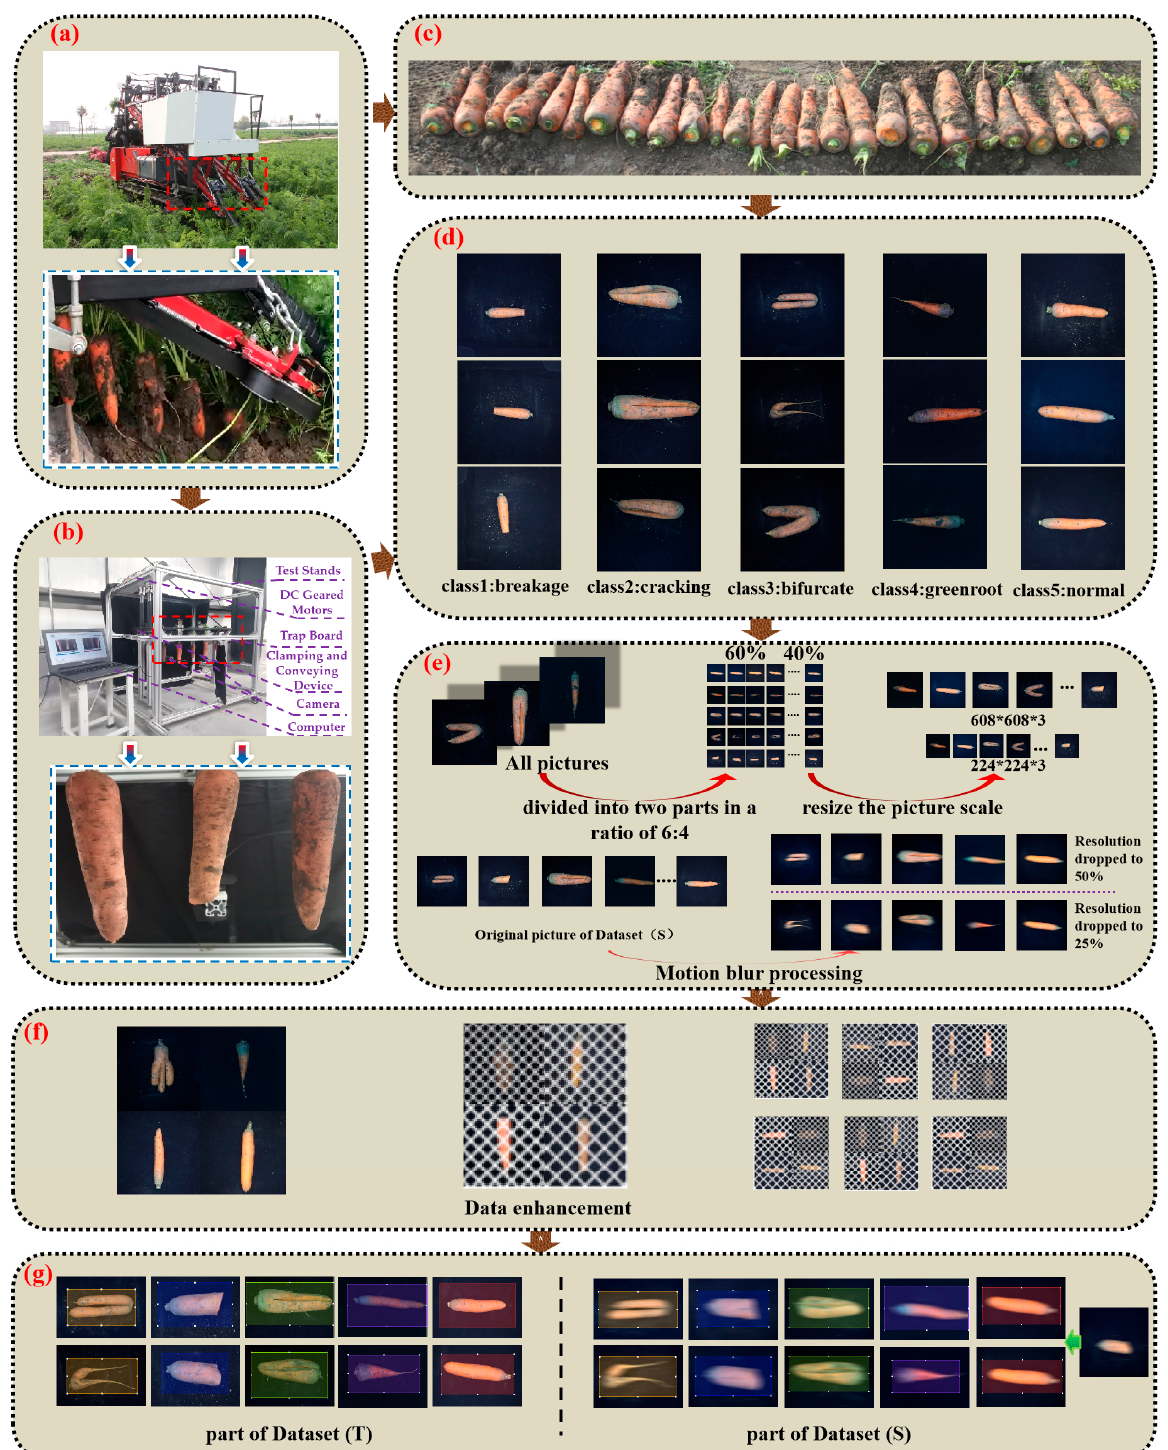
Figure 3. Acquisition of a carrot dataset. ( a ) Operation of the carrot combine harvester conveying system; ( b ) combine harvesting and collecting simulation system; ( c ) material acquisition for field tests; ( d ) classification of carrot defect types; ( e ) image preprocessing and dataset partitioning; ( f ) data enhancement; ( g ) partial dataset demonstration.